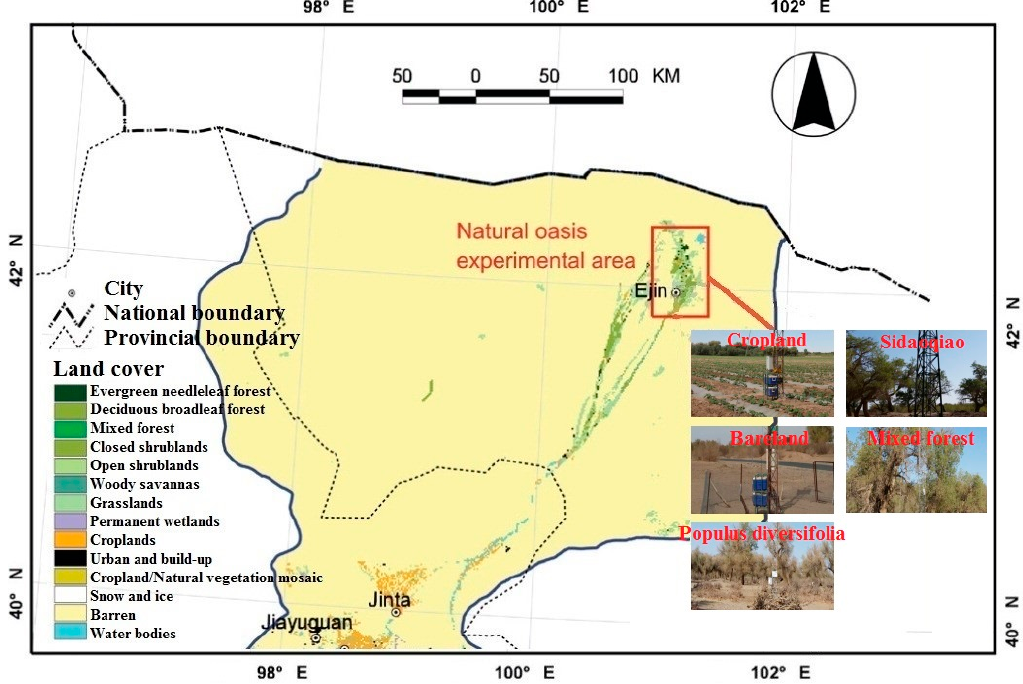
Figure 2. The location of the test area over the Heihe Watershed Allied Telemetry Experimental Research (HiWATER) experimental areas [49].